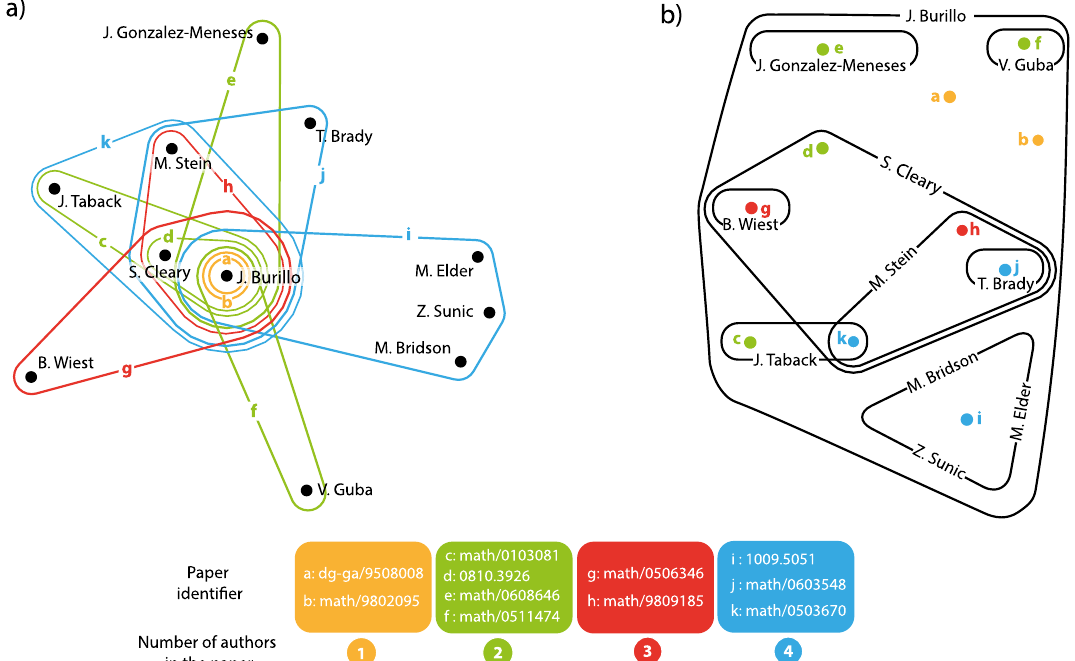
Figure 1. Schematic illustration of the co-authorship hypergraph (a) and of the dual hypergraph (b) . In panel (a) nodes are authors, and hyperlinks are co-authored Manuscript. The hyperlinks are labeled with letters and colours. The legend at the bottom of the Figure reports for each letter the corresponding Manuscript’s identifier in the ArXiv. In the legend, moreover, Manuscripts are grouped in coloured boxes, and different colours stand for a different number of coauthors: yellow papers are authored by a single Scholar, whereas green, red and blue Manuscripts are co-authored by two, three and four Scholars, respectively. Panel (b) contains a sketch of the dual representation, where nodes are now papers [labeled with the same colours and letters than in panel (a) ], and links are labeled with the name of the authors who participated in the co-authorship of the